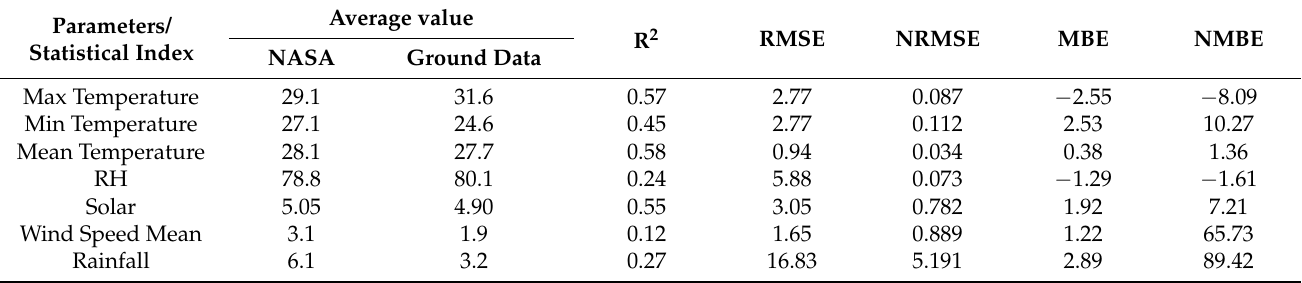
Table 7. Statistical index of the NASA POWER data